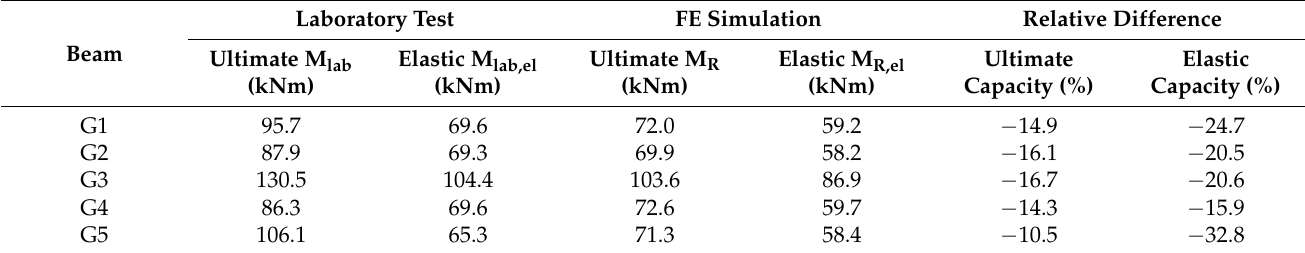
Table 5. Comparison of the load-carrying capacities obtained from laboratory tests analytical model.